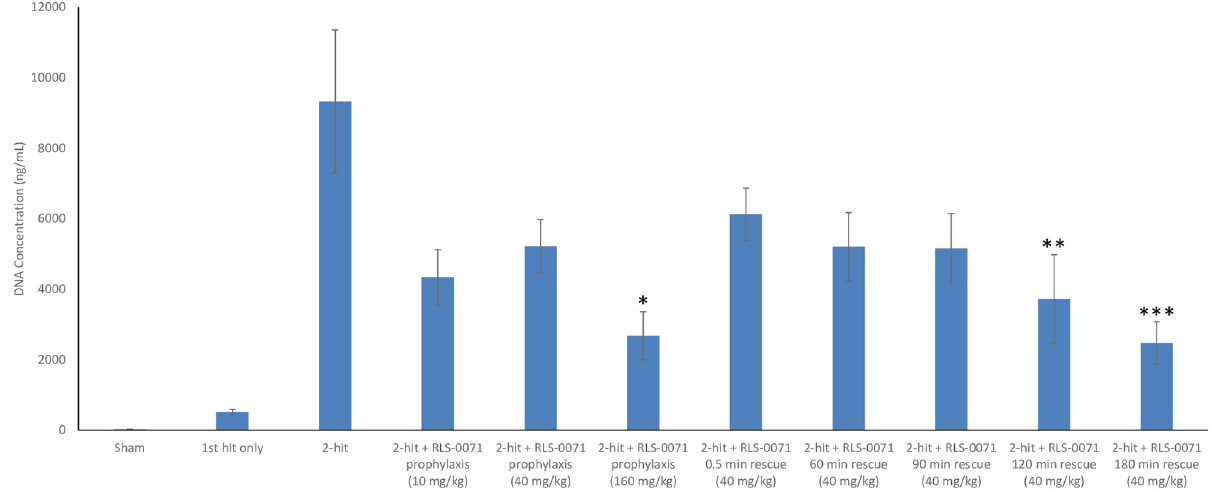
Fig 5. RLS-0071 reduces free DNA levels in the blood. Plasma was isolated from sham animals (n = 3) and the following groups at 4 hours after start of the experiments: first hit only (n = 3), 2-hit (n = 3), 2-hit + 10 mg/kg prophylactic dose RLS-0071 (n = 9), 2-hit + 40 mg/kg prophylactic dose RLS- 0071 (n = 4), 2-hit + 160 mg/kg prophylactic dose RLS-0071 (n = 5), 2-hit + 40 mg/kg rescue dose RLS-0071 at 0.5 min (n = 4), 2-hit + 40 mg/kg rescue dose RLS-0071 at 60 min (n = 3), 2-hit + 40 mg/kg rescue dose RLS-0071 at 90 min (n = 5), 2-hit + 40 mg/kg rescue dose RLS-0071 at 120 min (n = 3) and 2-hit + 40 mg/kg rescue dose RLS-0071 at 180 min (n = 3). Plasma samples were incubated with PicoGreen. Fluorescence was read at an excitation wavelength of 485 nm and an emission wavelength of 520nm in a microplate reader. All free DNA measurements for each animal were done in triplicate. Data are means and standard error of the mean. Statistical analysis was performed using bootstrap approach or Welch’s ANOVA. � denotes p = 0.026, �� denotes p = 0.039 and ��� denotes p = 0.005 compared to 2-hit animals.